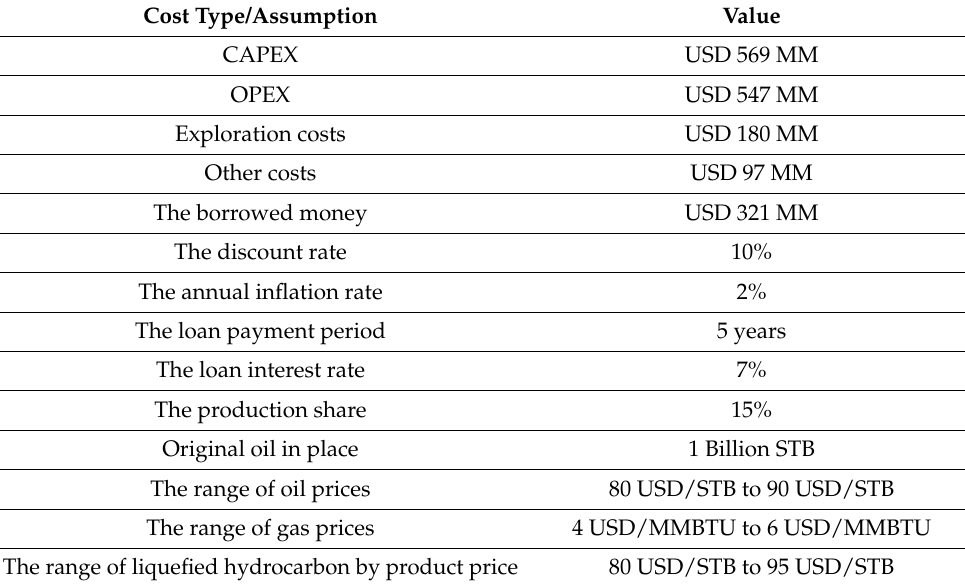
Table 1. Exploration costs, development costs, and the initial assumptions of XYZ field.